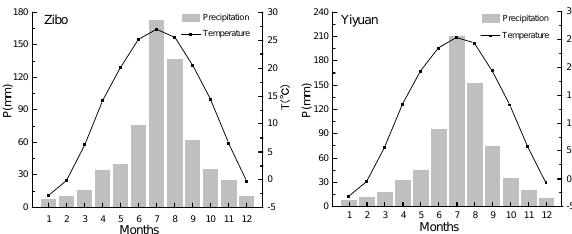
Figure 3. Monthly mean temperature ( T ) and precipitation ( P ) of Zibo (1952–1980) at Zibo Station and Yiyuan (1958–2005) at the Yiyuan Station, two meteorological stations close to the study site (Fig.